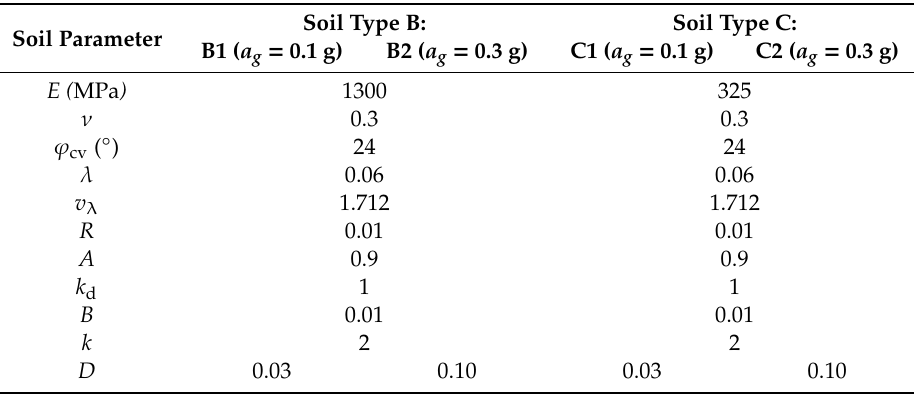
Table 5. Parameters adopted for the four models developed for the non-linear analyses Soil Type Soil Parameter